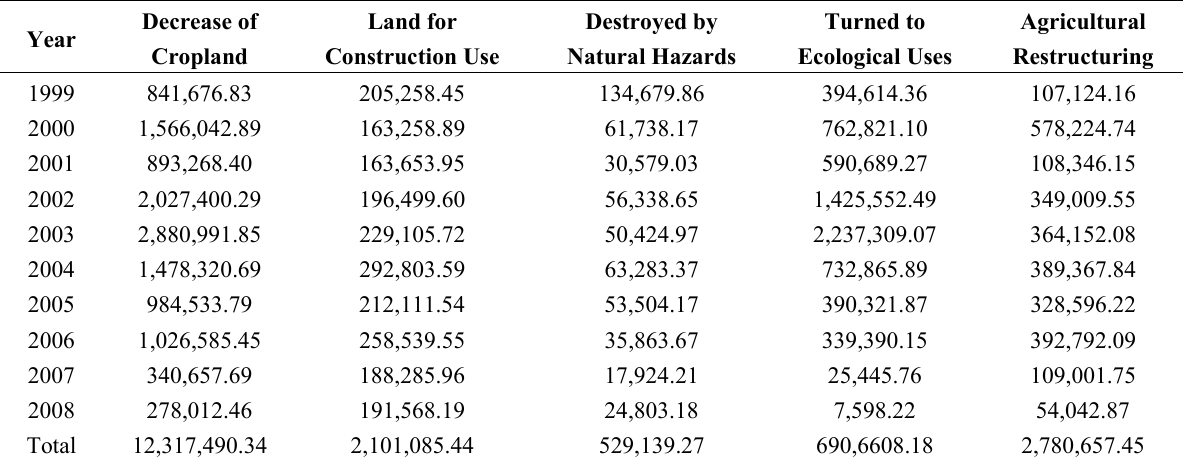
Table 1. The structure of decreased cropland during 1999–2008 (unit: ha). Source: Ministry of Land and Resources